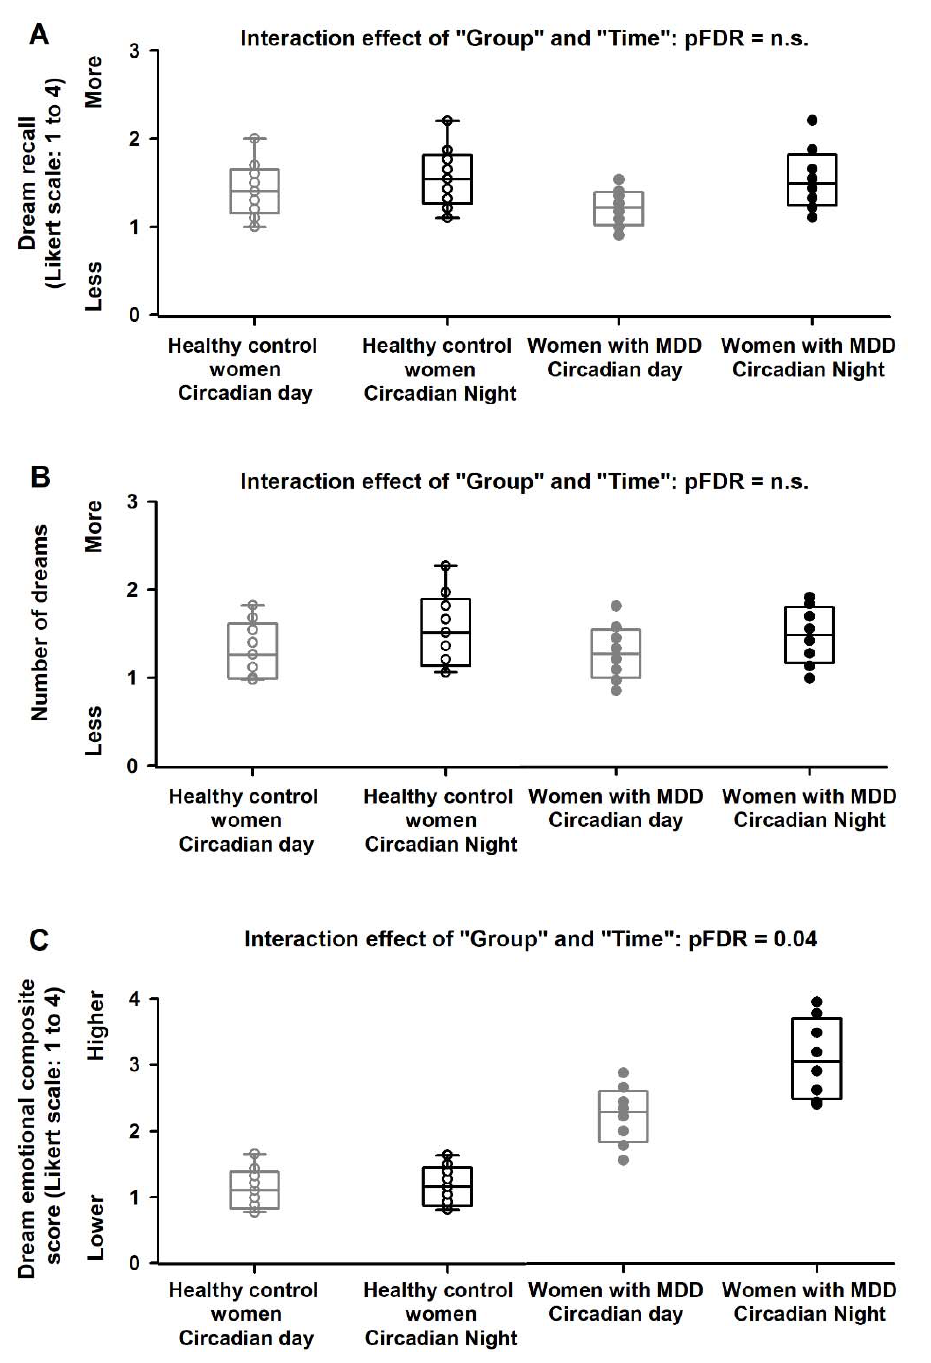
Figure 4. Circadian day/night modulation of dreaming in healthy control women and in women with MDD. We observed no significant interaction effects of “Group” and “Circadian day/night” for dream recall ( A ) and the number of dreams ( B ). In contrast, we observed a significant interaction effect of “Group” and “Circadian day/night” for the dream emotional composite score ( C ). Accordingly, women with MDD had significantly higher (negative) dream emotional composite scores after naps during the circadian night as compared to the healthy control women. Circles are individual data and boxes are the median and the interquartile